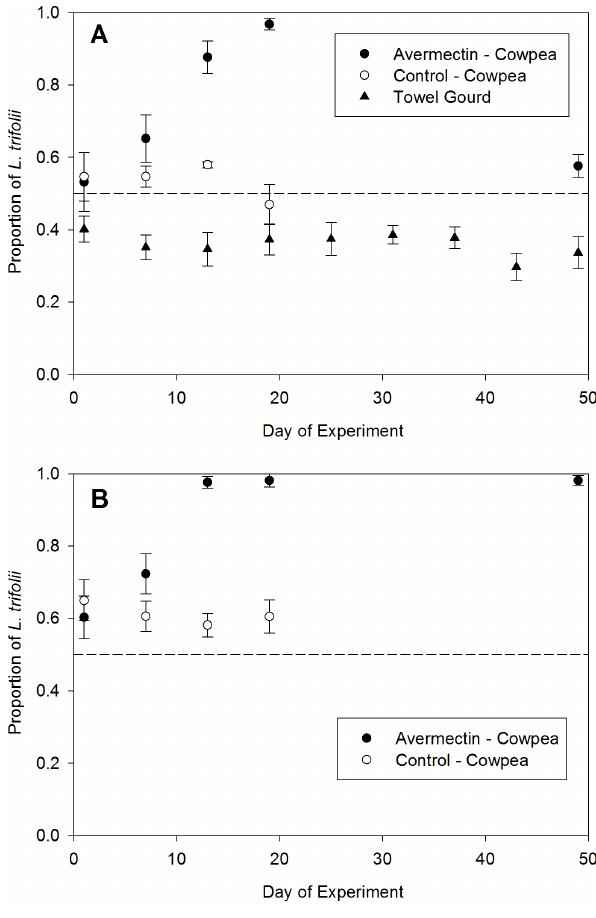
Figure 2. Liriomyza species composition during 2012. (A) mixed cropping systems of avermectin-treated and untreated cowpea, and adjoining plantings of towel gourd ( Luffa cylindrica ), and (B) plantings of cowpea that were treated with avermectin or were untreated controls. Avermectin treatments were made on days 1, 7, and 13 of the experiment following Liriomyza sample collections. Data points represent means 6 SEM.